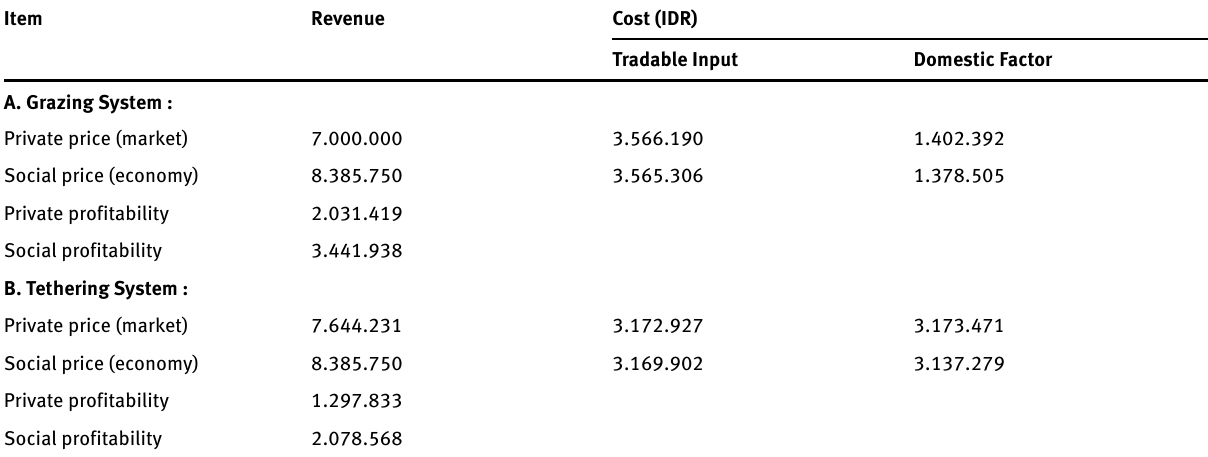
Table 3: Cost, revenue, and profit on the level of the private and social price of beef cattle at upstream of Benain-Noelmina watershed area